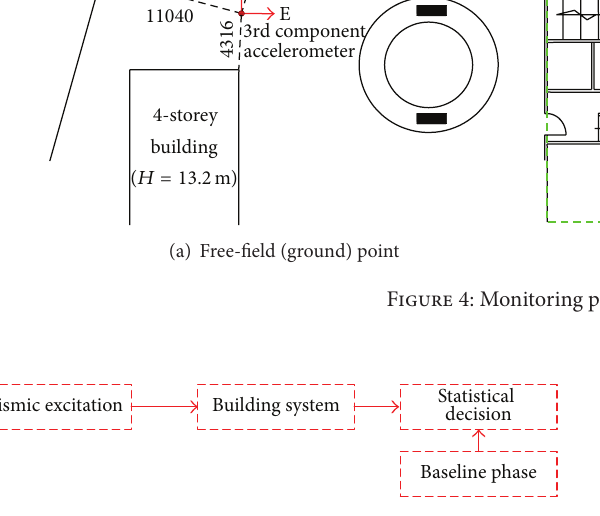
Figure 5: Scheme of the statistical decision of